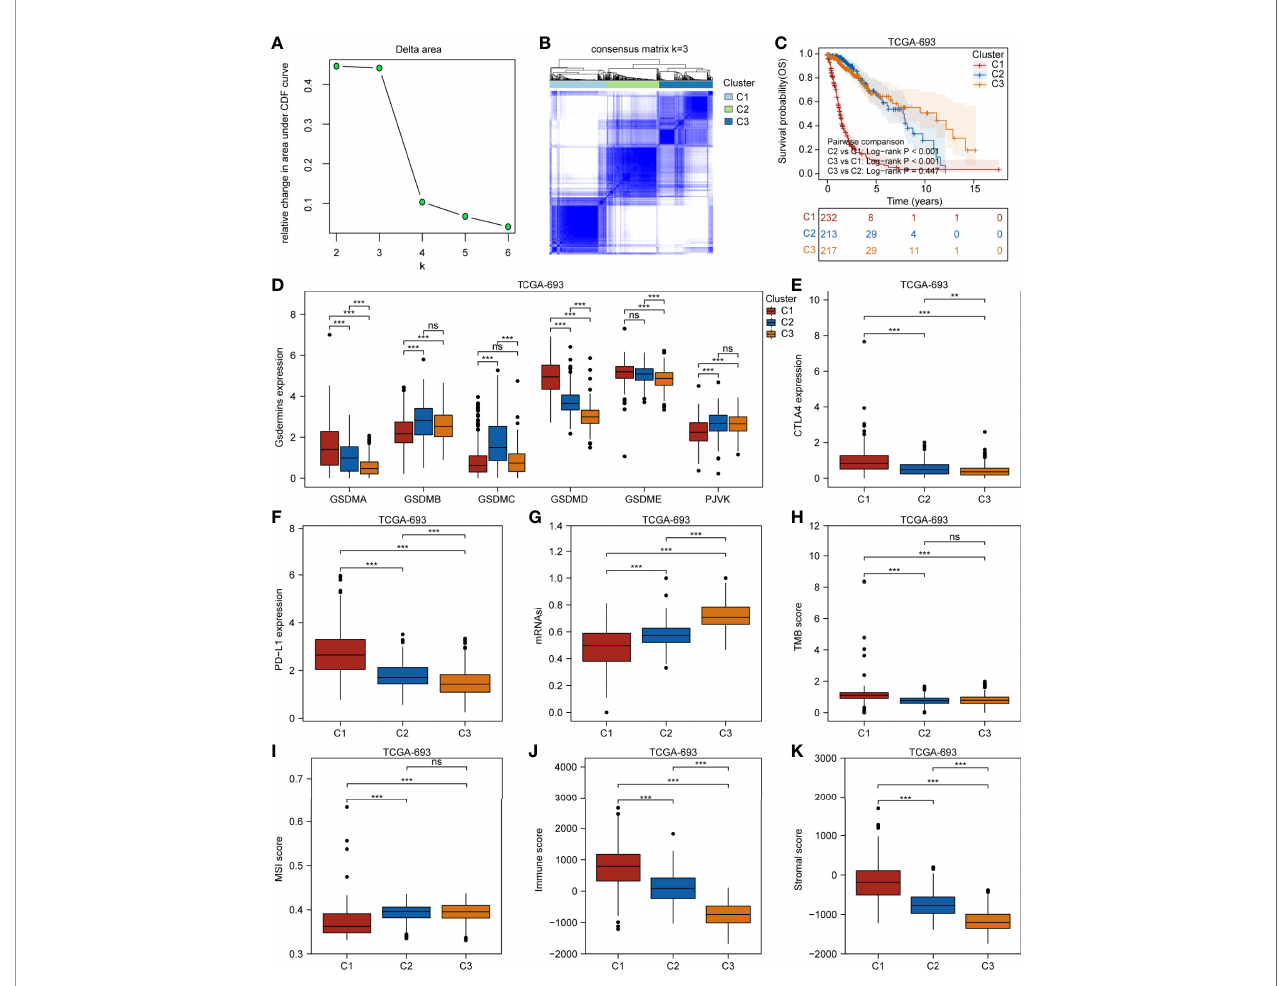
FIGURE 3 | Three glioma pyroptosis subtypes based on the expression of gasdermin-related genes. (A) Relative change in area under CDF curve for k = 2 to 6. (B) Consensus clustering matrix for k = 3. (C) Survival analysis of the three pyroptosis subtypes C1 – C3. Boxplots showing comparison of the gasdermin expression (D) , CTLA4 expression (E) , PD-L1 expression (F) , mRNAsi (G) , TMB score (H) , MSI score (I) , immune score (J) , and stromal score (K) in the three pyroptosis subtypes. **P<0.01; ***P<0.001; ns, not signi fi